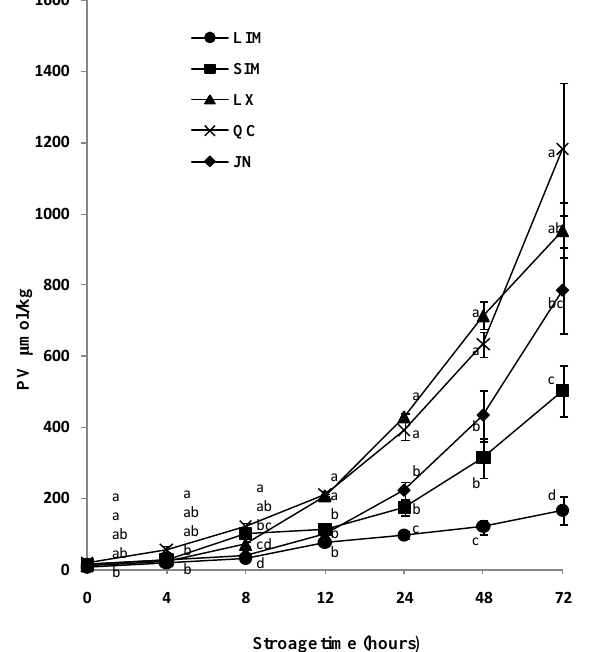
Figure 1. Comparison of lipid hydroperoxides at different times in the longissimus dorsi (ld) muscle of five cattle breeds (  mol/kg) (N = 8). Data are presented as mean  SD. Values with different superscript letters are significantly different